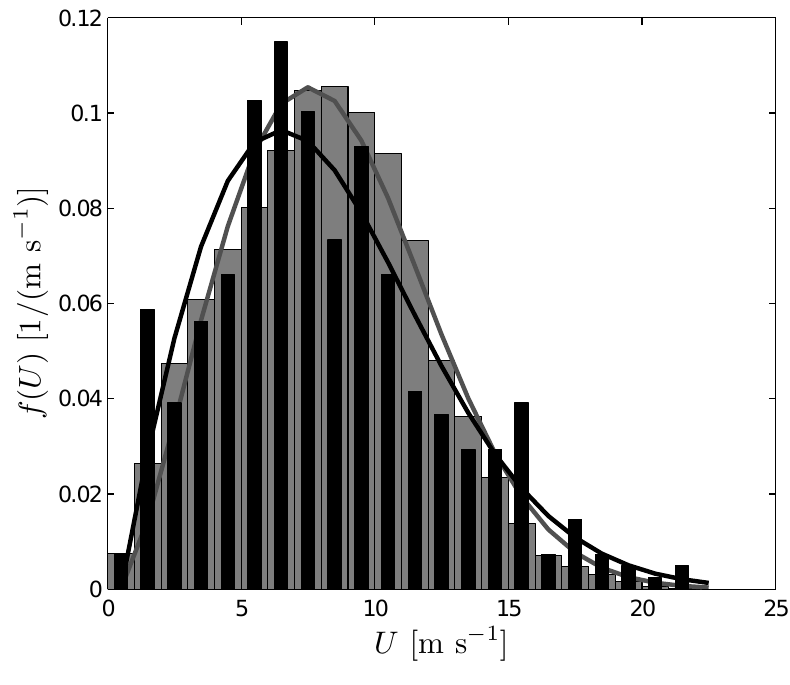
Figure 9. Histogram of wind speed observed at FINO-2 extrapolated from 102 m to 10 m from 1 July 2007 to 19 October 2010 total of 146,910 samples (in grey) with Weibull fit using WAsP, and wind speed observed from Envisat ASAR from 2003 to 2010, total of 409 samples (in black) with Weibull fit using